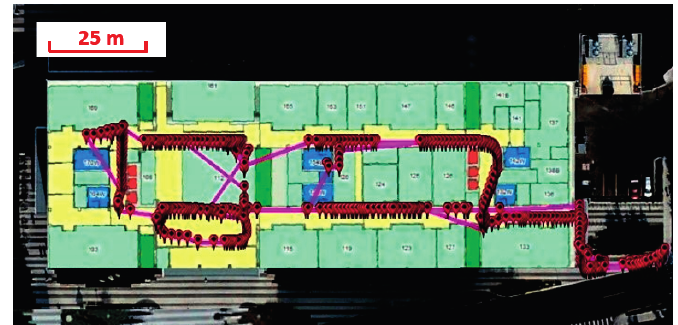
Figure 10. WiFi-aided MM result at EEEL.